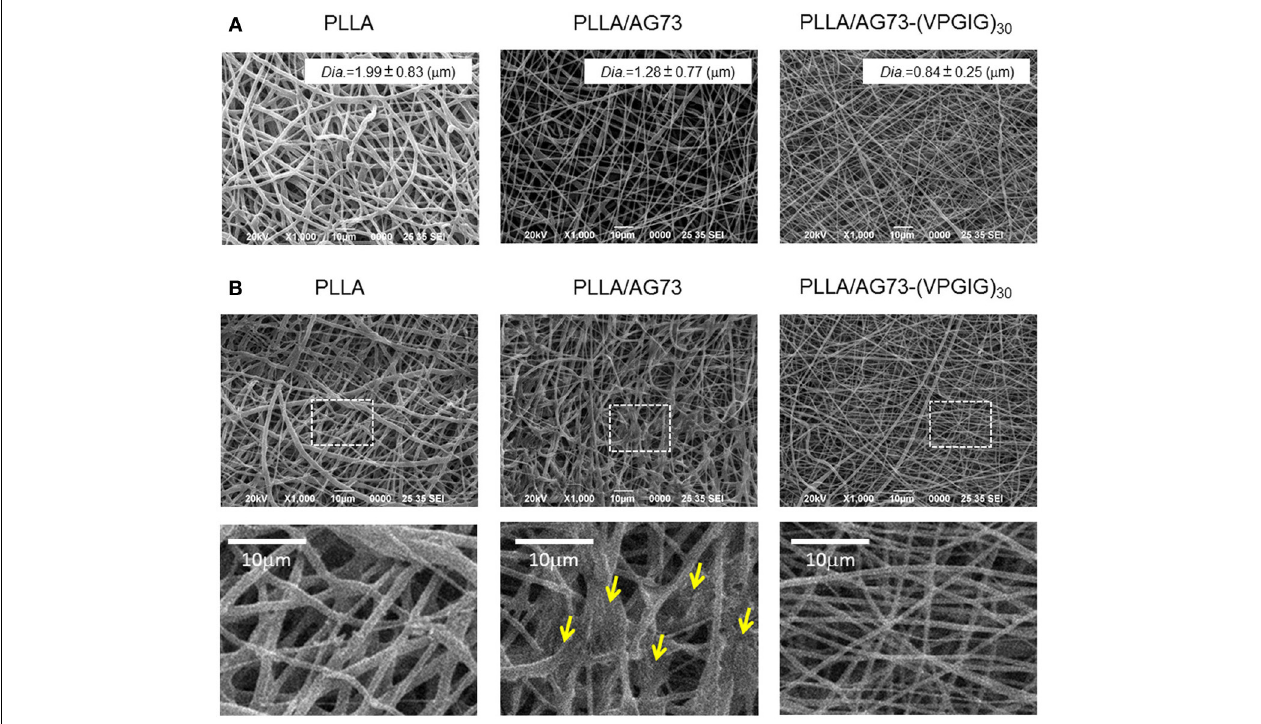
FIGURE 2 | SEM images of electrospun PLLA, PLLA/AG73, and PLLA/ AG73-(VPGIG) 30 micro-fibers (A) before and (B) after immersion in PBS for 24h at 37 ◦ C. Yellow arrows indicate fusion points.